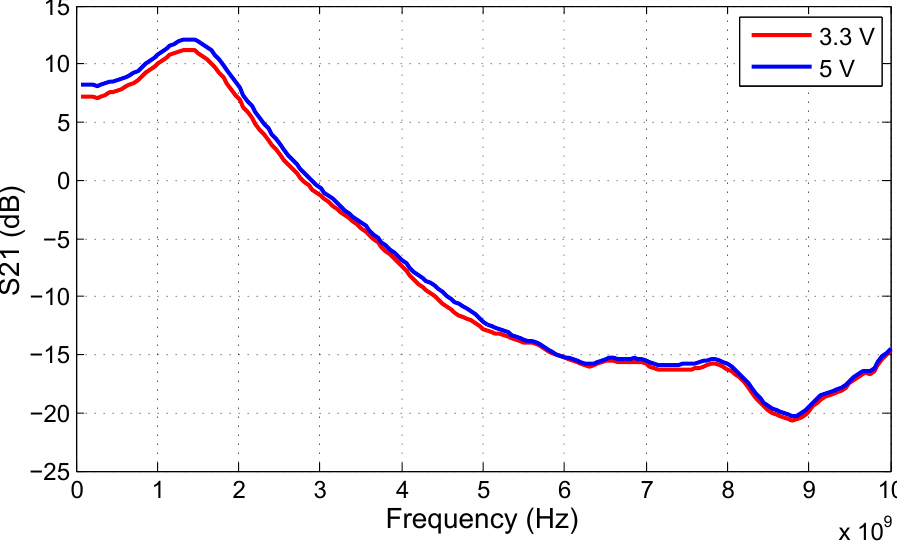
Figure 19. S21 of the proposed LCR driver circuit measured with 10 Ω dummy